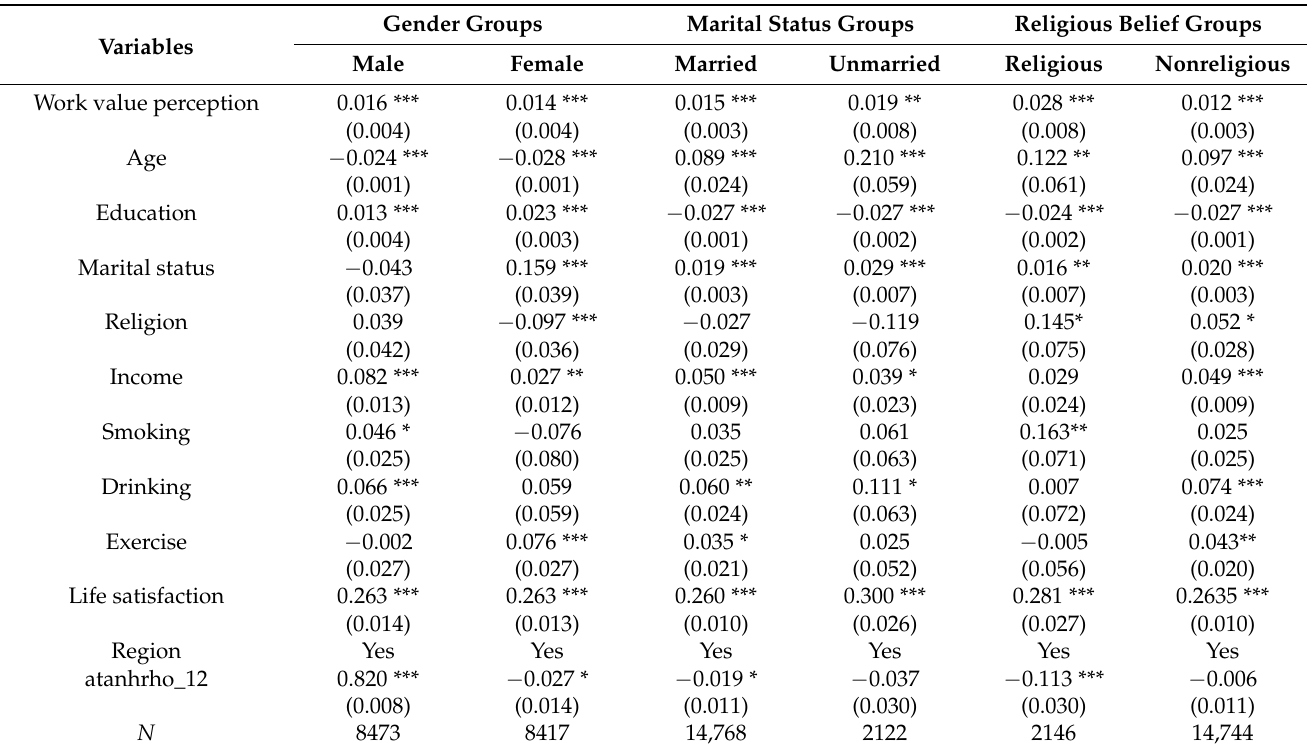
Table 6. Impacts of work value perception on workers’ physical health among different subgroups (IV-ordered probit).